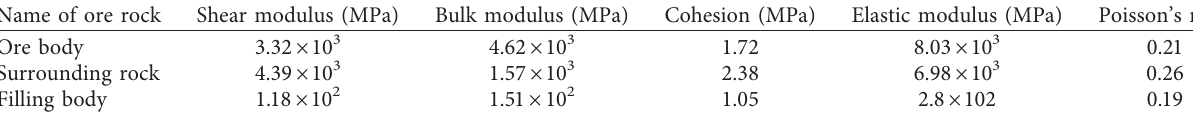
Table 1: Mechanical parameters of backfill and ore in a certain ore in Eastern Hebei province. Name of ore rock